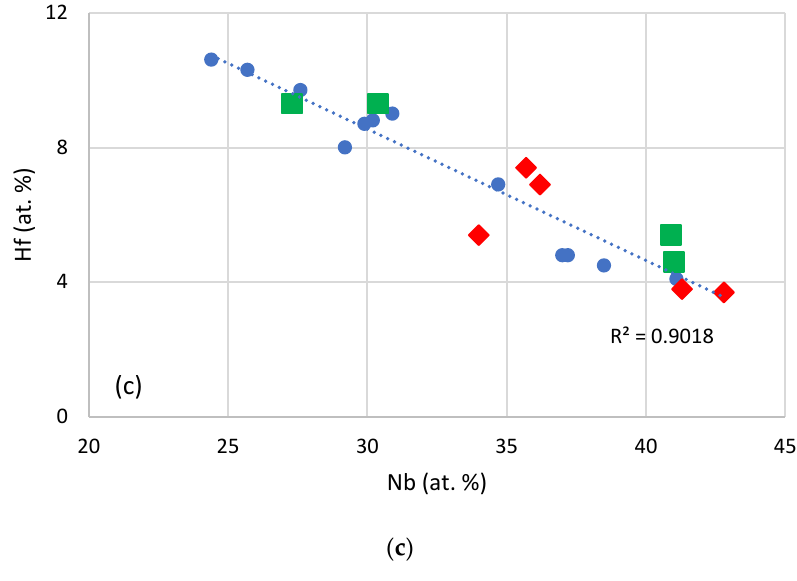
Figure 8. ( a ) Si versus Ti in Nb 5 Si 3 , ( b ) Al versus Ti in Nb 5 Si 3 , ( c ) Hf versus Nb in Nb 5 Si 3 . Squares and diamonds show data for the alloys NbSiTiHf-5Al-5Cr and NbSiTiHf-5Al, respectively. The data is for Nb 5 Si 3 silicides in alloys studied in our research group (see [34] and [5,25]). In ( a ) series a (R 2 = 0.9928) with alloying element additions of Al, Cr, Ge, Hf, Si, Sn, Ti; series b (R 2 = 0.9674) Al, B, Cr, Ge, Hf, Mo, Si, Sn, Ta, Ti; series c (R 2 = 0.978) Al, B, Cr, Ge, Hf, Si, Sn, Ta, Ti; series d (R 2 = 0.9621) Al, B, Cr, Ge, Hf, Mo, Si, Ta, Ti; and series e (R 2 = 0.8421) Al, B, Cr, Hf, Mo, Si, Sn, Ta, Ti. In ( b ) series a (R 2 = 0.9218) with alloying element additions Al, B, Cr, Ge, Hf, Si, Sn, Ti; series b (R 2 = 0.9232) Al, B, Cr, Ge, Mo, Si, Sn, Ta, Ti; series c (R 2 = 0.8929) Al, B, Cr, Hf, Si, Sn, Ti; and series d (R 2 = 0.9915) Al, B, Cr, Mo, Si, Sn, Ta, Ti. In ( c ) blue data points are for Nb 5 Si 3 silicides with alloying element additions of Al, B, Cr, Ge, Hf, Si, Sn, Ti.